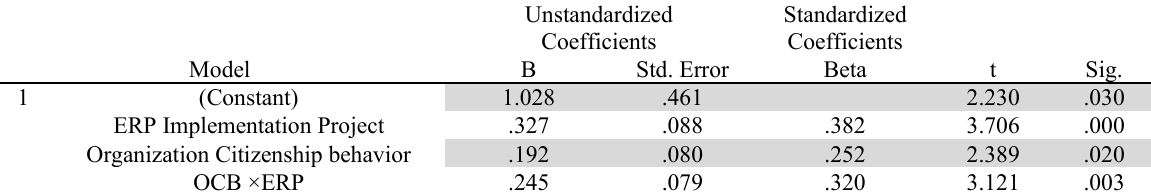
The direct effect of ERP project implementation on firm performance Unstandardized Coefficients Model